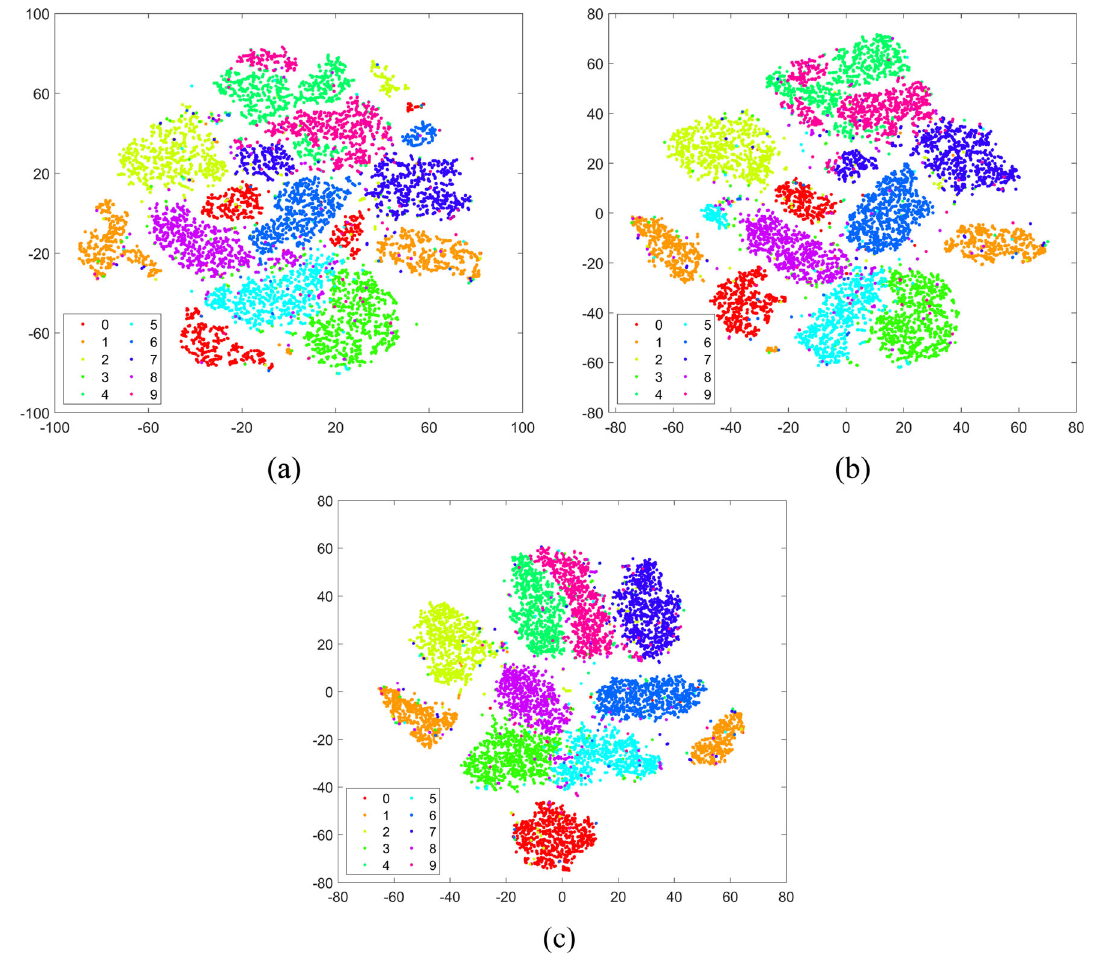
Fig. 4 Visualization of original data and abstract feature on MNIST dataset: a original data, b the ELM-AE, and c the FELM-AE